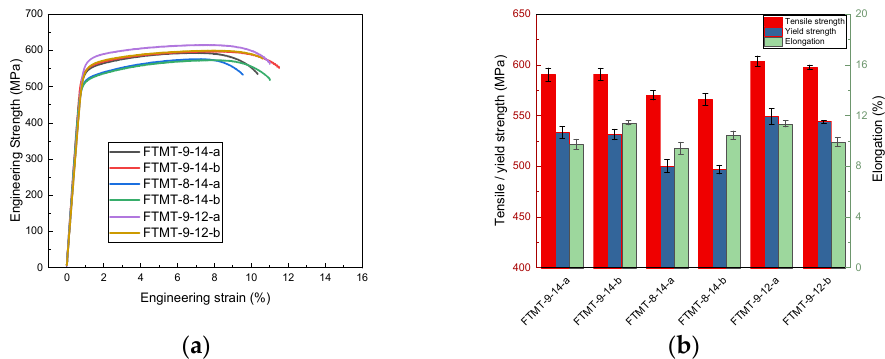
Figure 4. Stress–strain curves and tensile properties of Al-Mg-Zn-Cu alloy after FTMT process with different parameters: ( a ) stress–strain curves; ( b ) tensile properties.